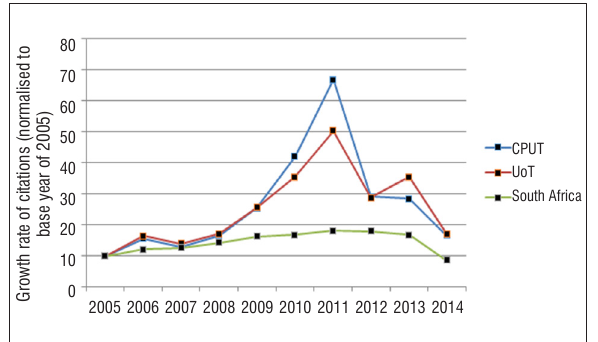
Figure 2: Growth in rate of citations over a 10-year period